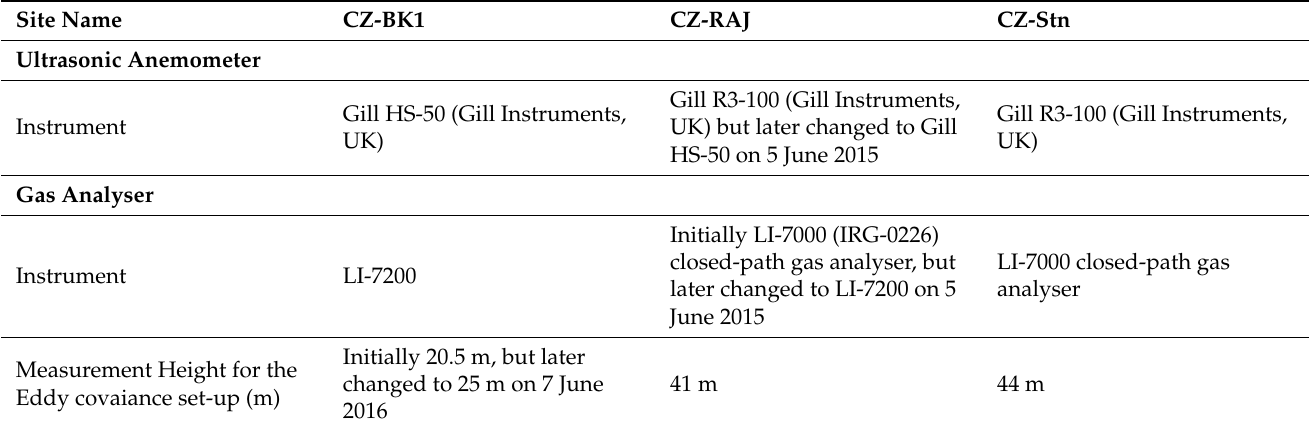
Figure A4. Correlation of daily Diffusion Index (DI) with daily Clearness Index (CNI) for May– September of 2012–2016 in the wet spruce forest site in Bílý K˘rí˘z (CZ-BK1), showing diffuse radiation on partly cloudy days (highest point). Table A1. Description of the eddy covariance systems at the investigated sites.